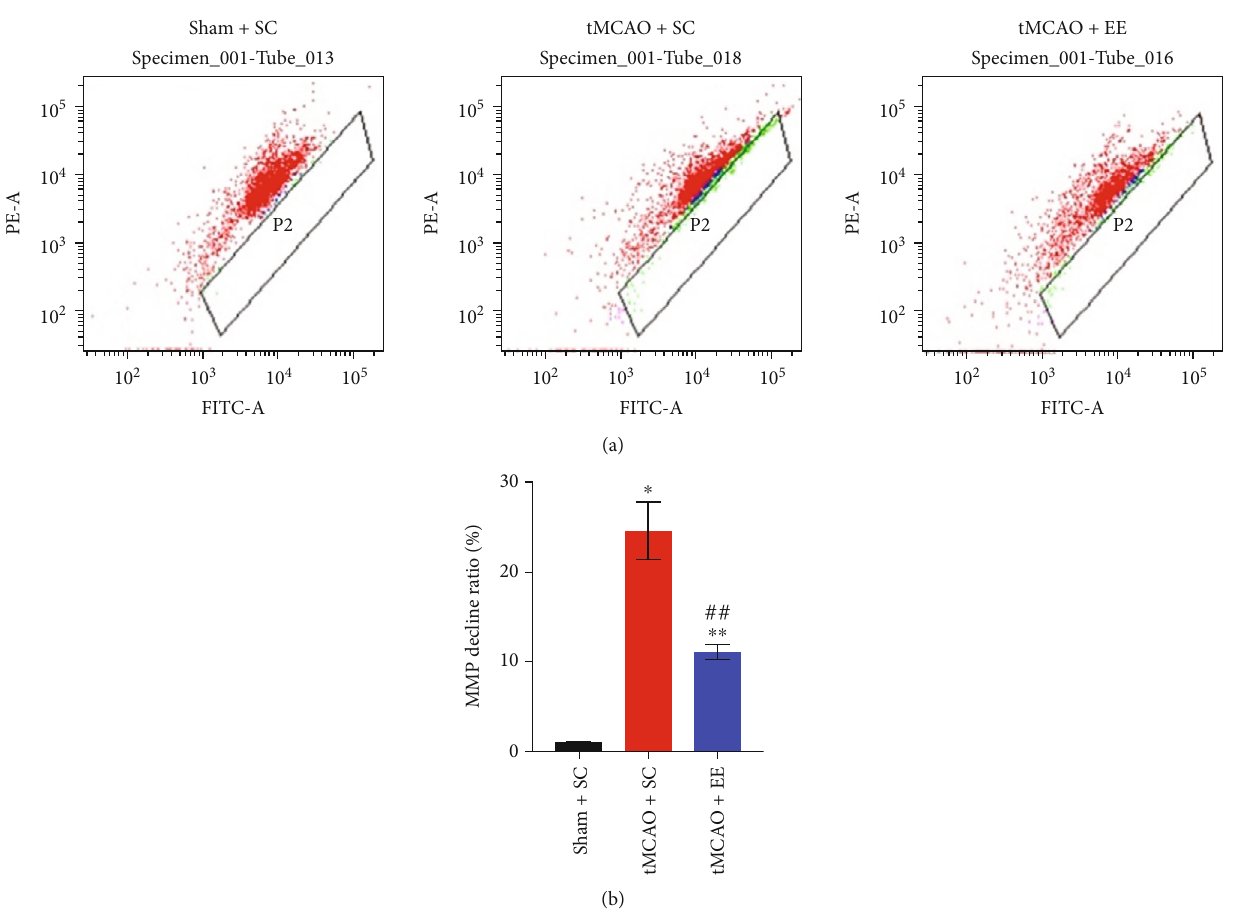
Figure 7: (a) The results of fl ow cytometry. (b) The decline ratio of mitochondrial membrane potential (MMP) calculated according to the ratio of the number of red and green mitochondria. ∗ P < 0 : 05 and ∗∗ P < 0 : 01 vs . sham+SC group; ## P < 0 : 01 vs . tMCAO+SC